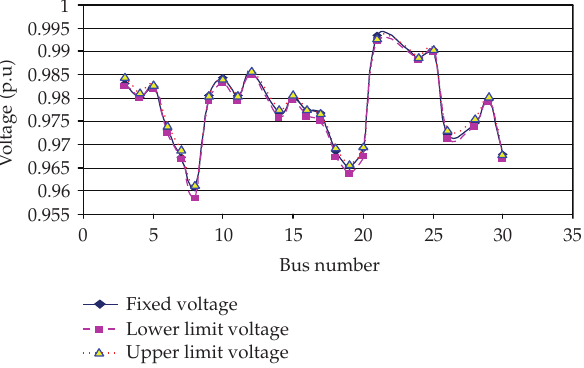
Figure 4: Voltage profile for line